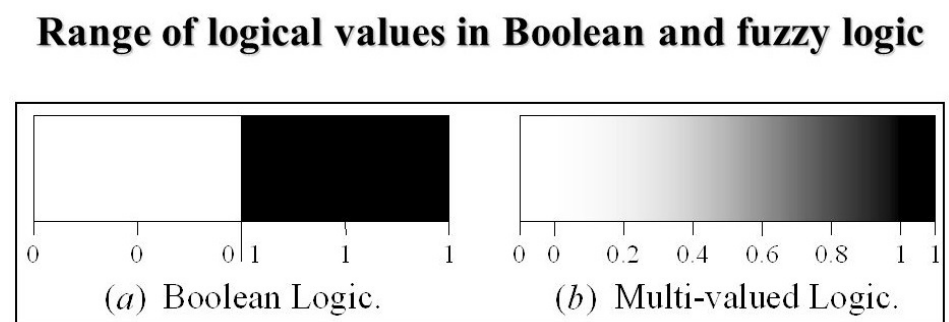
Figure 5. Fuzzy logic and Boolean logic .